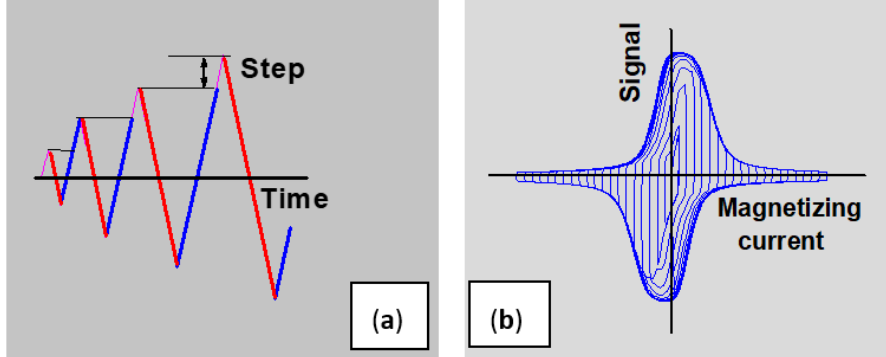
Figure 4. Time variation in magnetizing current ( a ) and the detected permeability loops ( b ) [17]. Once the measured permeability loops were obtained, an evaluation process was performed. Instead of keeping the signal and the magnetizing field in shapes of continuous time-dependent functions, it was practical to interpolate the family of data for each sample into a discrete square matrix, m ≡ m ( h a , h b ), with a suitably chosen step, ∆ h a = ∆ h b . If the permeability values determined from the measured permeability loops are used, this is called a permeability, or m , matrix. (Other matrices can also be calculated, such as the hysteresis loops matrix, whose elements include the integrated permeability along the field, h a ). A 3D representation of a permeability matrix is shown in Figure 5. The sweeping magnetizing field, h a , is given on the X axis and the amplitude of the corresponding minor loop, h b , is given on the Y axis, while the calculated permeability (from the measured loops) is given on the Z axis. The m matrix elements were compared with the corresponding matrix element of the reference sample (as received). The modification of the normalized matrix elements as functions of the degradation parameter characterized the actual material degradations due to any external impact. A large data pool was calculated (with hundreds of matrix elements), and those descriptors which were the most sensitive to the actual material degradation were chosen from these matrix